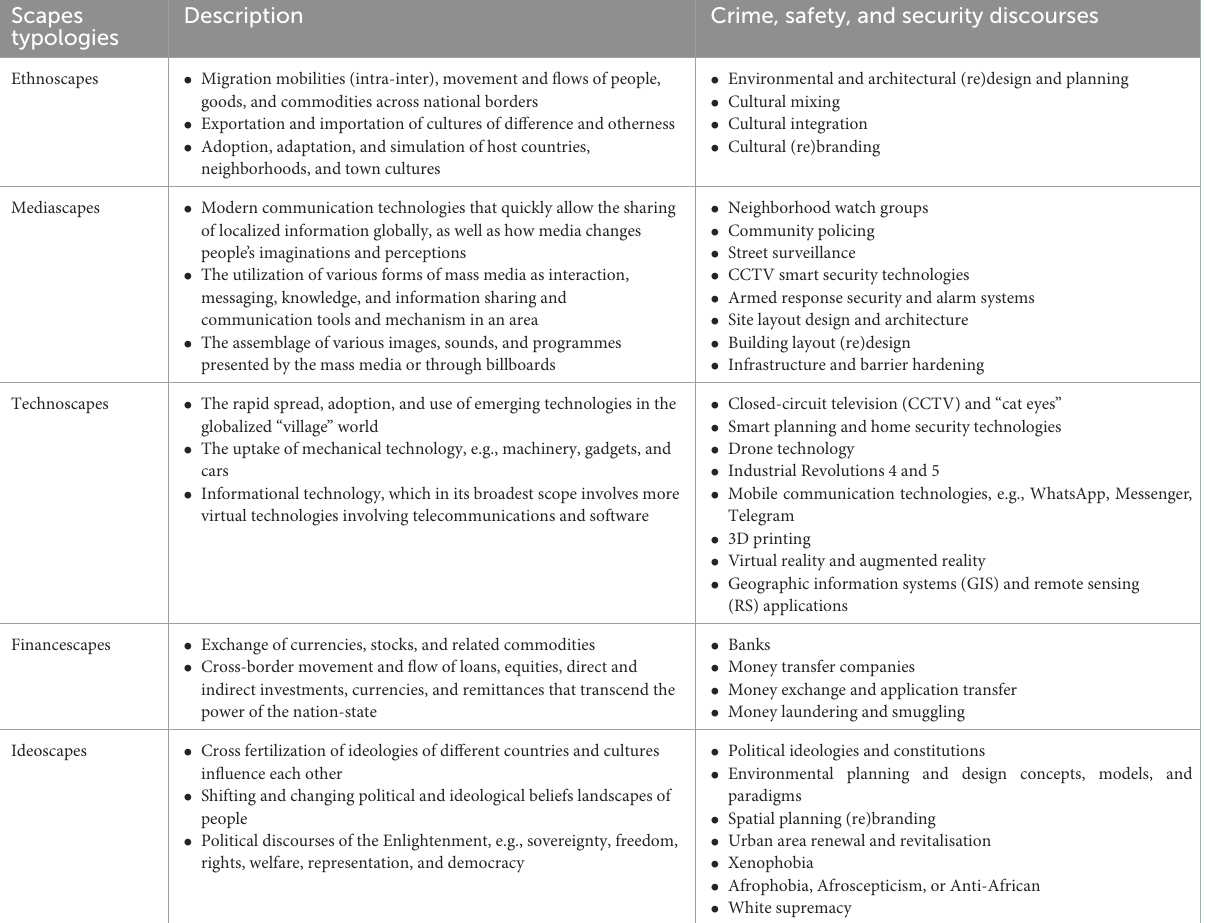
TABLE 2 Unraveling Appadurai’s (1996) five scapes: reduction and application to crime, safety, and security in built environment dimensions. Scapes